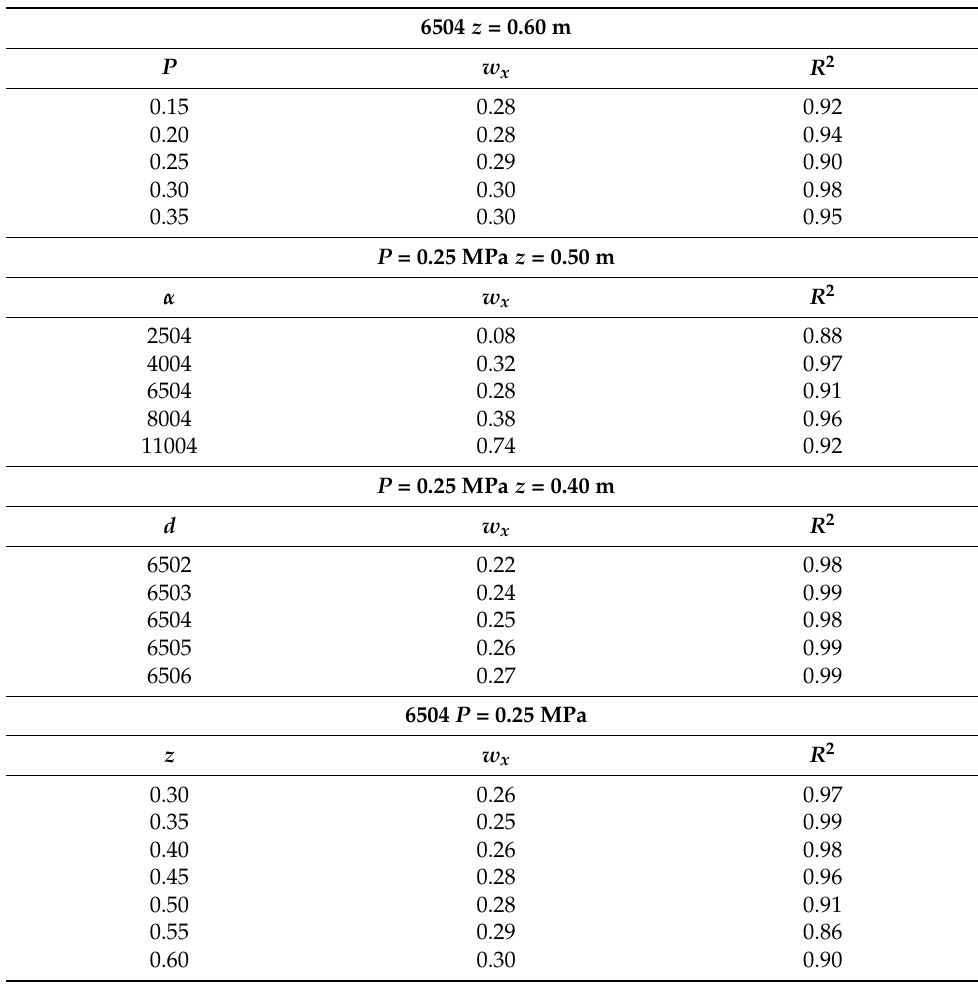
Table 4. w x and the fitting degrees for different spray parameters.